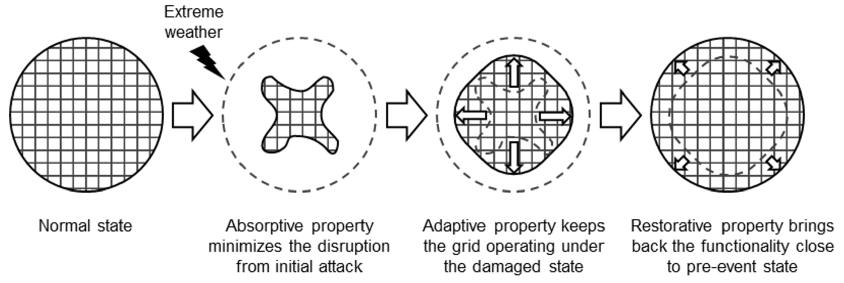
Figure 2. Three resilient properties of the grid.